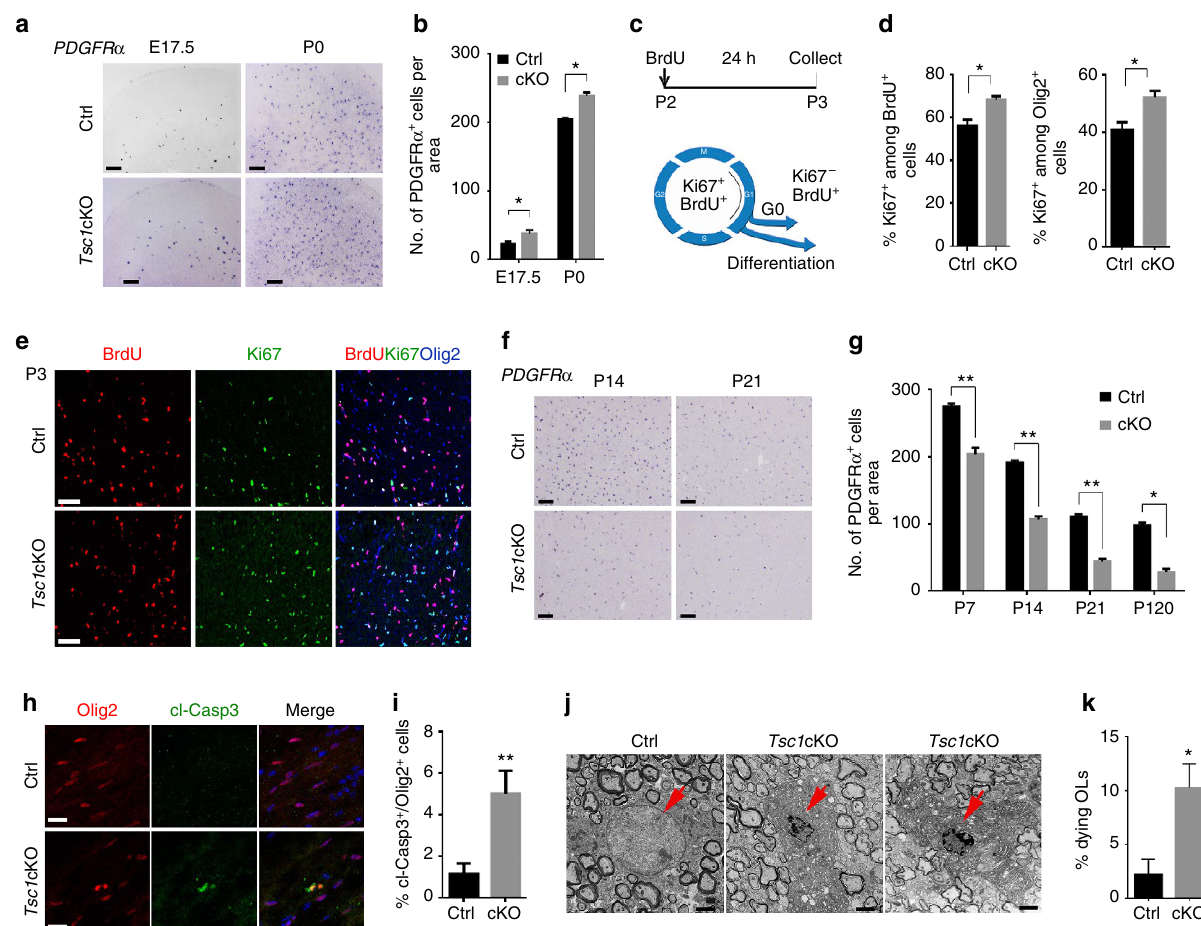
Figure 4 | Tsc1 ablation leads to OPC loss and inhibits cell cycle exit. ( a ) Expression of PDGFR a examined by in situ hybridization in the cortex of control and Tsc1 cKO mutants at E17.5 and P0. Scale bar, 100 m m. ( b ) Numbers of PDGFR a þ cells in the cortex per unit area (0.4mm 2 ) in control and Tsc1 cKO mutants at indicated stages. Data represent the mean ± s.e.m. from three animals. * P o 0.05; Student’s t -test. ( c ) Control and Tsc1 cKO mice at P2 were pulse-labelled with BrdU for 24h. Cortical sections collected at P3 were immunostained with antibodies to BrdU, Ki67 and Olig2. ( d ) The percentage of BrdU þ and Olig2 þ OPCs that are Ki67 þ in control and Tsc1 cKO cortices. Data represent the mean ± s.e.m. from three animals. * P o 0.05; Student’s t -test. ( e ) Cortical sections at P3 were immunostained with BrdU, Ki67 and Olig2. Scale bar, 50 m m. ( f ) Expression of PDGFR a by in situ hybridization in cortices of control and Tsc1 cKO mutants at indicated stages. Scale bar, 100 m m. ( g ) Quantification of PDGFR a þ OPCs in the cortex per unit area (0.4mm 2 ) in control and Tsc1 cKO mutants at indicated stages. Data represent the mean ± s.e.m. from three animals. ** P o 0.01; Student’s t- test. ( h , i ) Representative images ( h ) and percentage ( i ) of cells expressing cleaved Caspase 3 (cl-Casp3) among Olig2 þ cells in the cortex of control and Tsc1 cKO mutants at P3. Data represent the mean ± s.e.m from three animals. ** P o 0.01; Student’s t -test. Scale bar, 25 m m. ( j , k ) Representative electron microscopy images ( j ) and quantification ( k ) of dying OLs in the spinal cord of Tsc1 cKO mutants at P14. Data represent the mean ± s.e.m from three animals. Scale bar, 2 m Elevation of Tsc1 -mutant OL cell death upon differentiation .